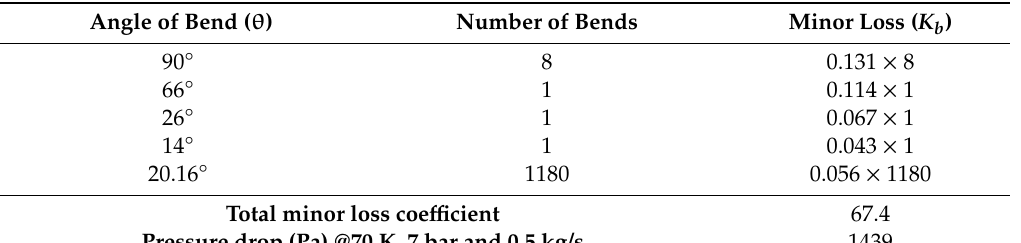
Table 2. Total minor loss coe ffi cient of the HTS power cable between Munsan and Seonyu. substation. Angle of Bend ( θ